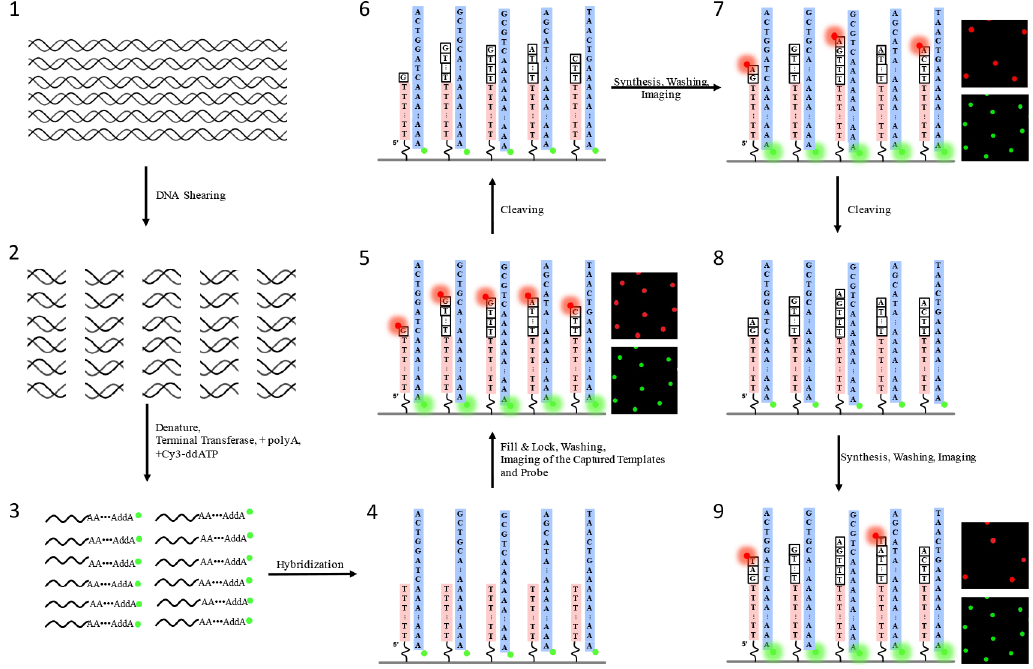
Fig 1. Sample preparation and sequencing process for single molecule sequencing of biological samples.